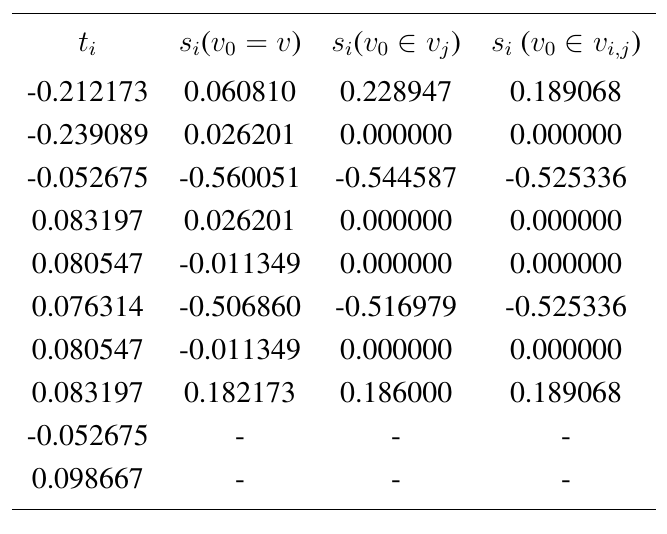
Table 1. Precomputed weights in radial layers (n = 8).